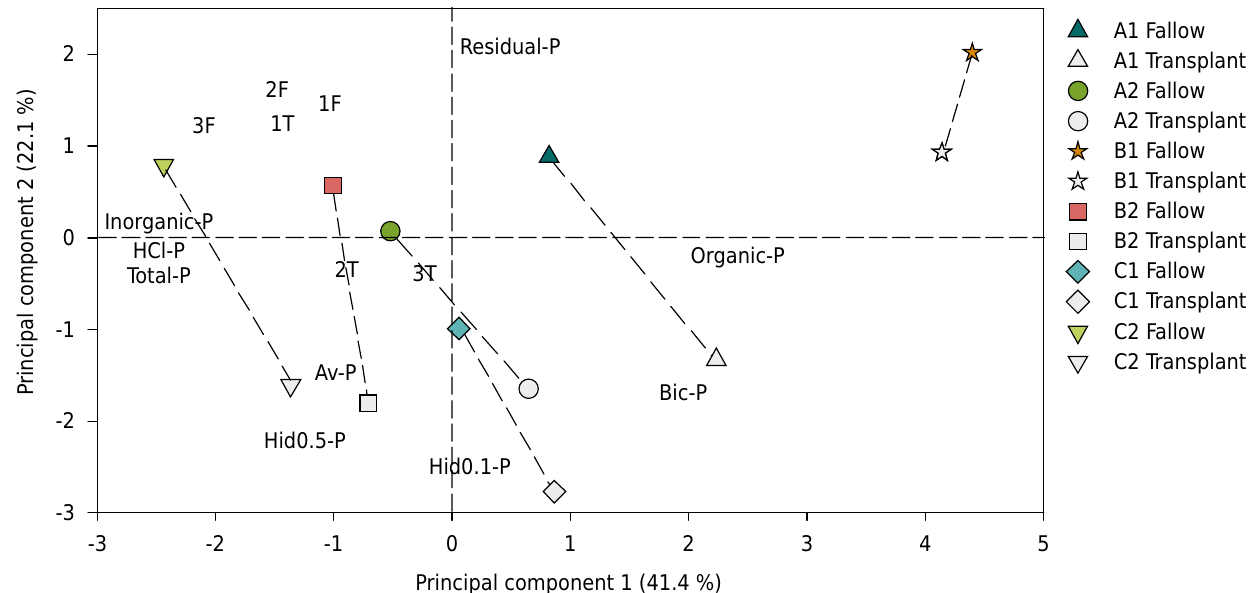
Figure 4. Projection of sediment P forms in the first factorial plan of the Principal Component Analysis (PCA) of the suspended sediment collected upstream and downstream in the Sub-basins A, B, and C, and during rising limb (1), peak discharge (2), and recession limb (3) at the catchment outlet, in two storm events occurred in the periods of fallow (F) and tobacco transplantation (T), in Agudo catchment, Rio Grande do Sul, Brazil. Numbers in parentheses indicate the percentage of variance explained by each axis.